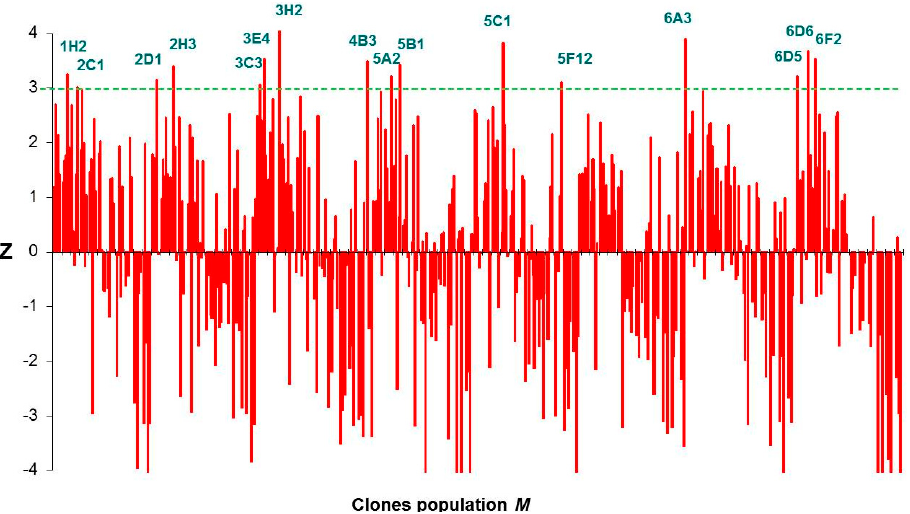
Figure 5. Graphic representation of the Z -scores of DHAK mutant population M .